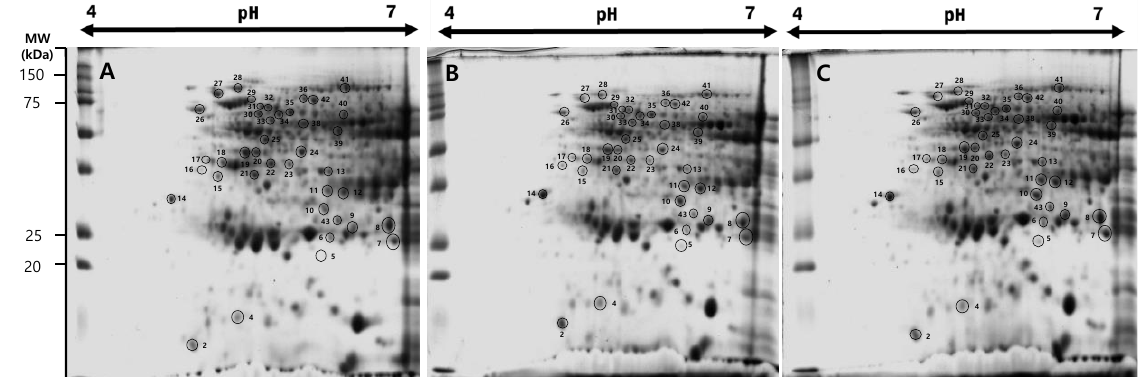
Figure 5. The 2DE-images of seed proteome extracted at 24 h after germination. Protein extracts of embryos from control ( A , 0 MPa + 0 mM H₂O₂) and drought stress-treated sorghum seeds ( B , −0.5 MPa + 0 mM H₂O₂ ), and drought stress and hydrogen peroxide treated seeds ( C , −0.5 MPa + 100 mM H₂O₂) were separated by 2DE (pH 4–7, 12.5% SDS-PAGE). Table 1. Differentially expressed proteins identified in sorghum seed embryos at 24 h after treatment.